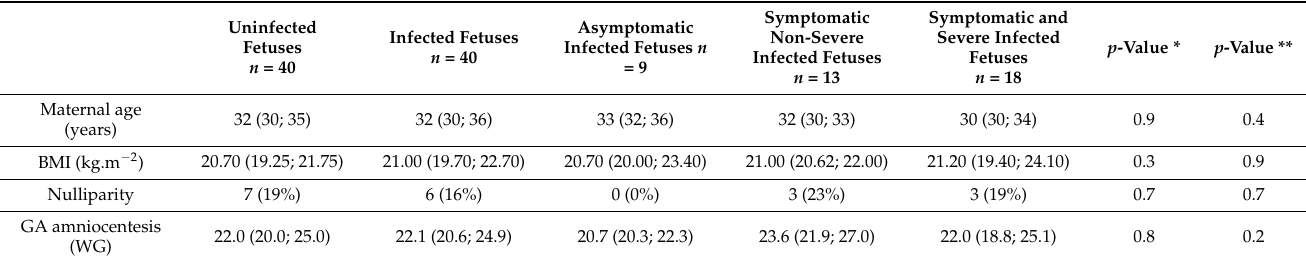
Table 1. Population characteristics.